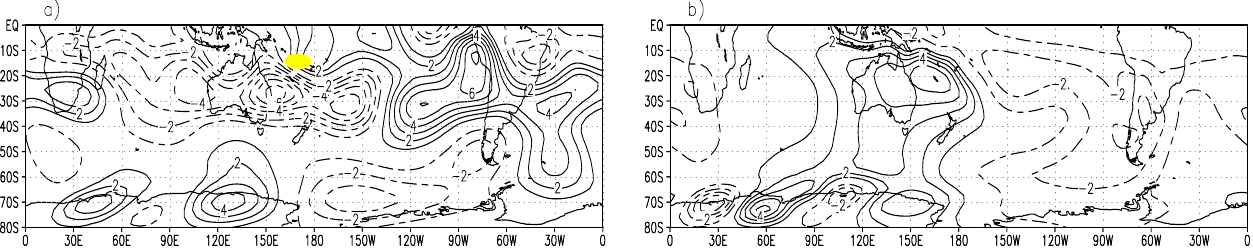
Fig. 4. Stream function anomalies (1 × 10 − 6 m 2 s − 1 ) at 250hPa (a) and 850hPa (b) , on day 10 of integration, corresponding to − σ basic state experiment with the forcing at 170 ◦ E–15 ◦ S (see dot in the Figure 4 : Stream function anomalies (1x10 -6 m 2 s -1 ) at 250 hPa (a) and 850 hPa (b), on day 10 of integration, corresponding to - σ basic state experiment with the forcing at 170ºE-15ºS (see gray dot in the figure)